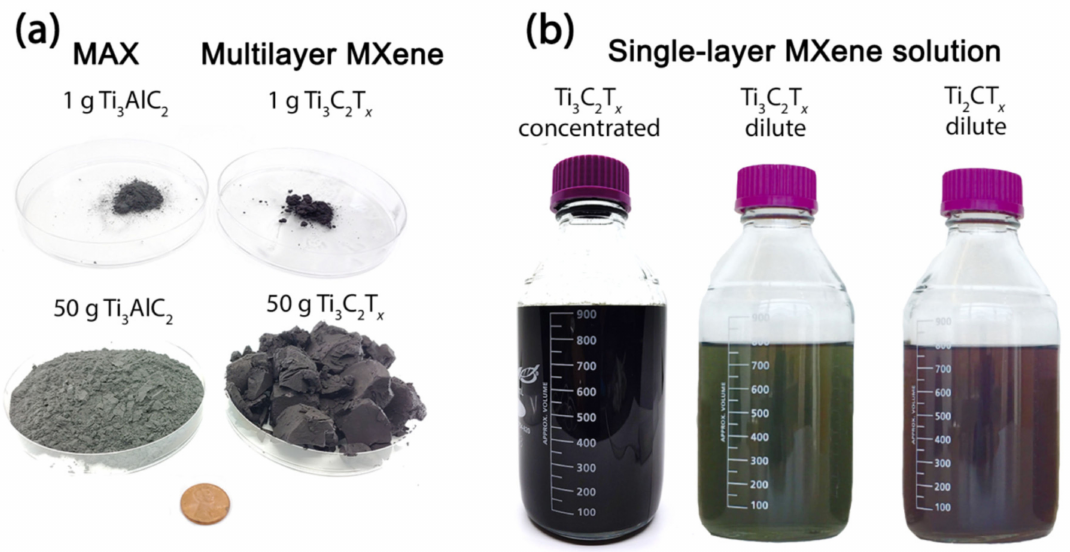
Figure 7. Color change shown by MAX phase and derived MXene. ( a ) Images of the parent Ti 3 AlC 2 MAX phase used in synthesis of the 1 g and 50 g Ti 3 C 2 T x samples. ( b ) Delaminated MXene solutions in 1 L bottles depicting their characteristic colors.Reprinted with permission from refs. [72] (Shuck et al., 2020) and [42] (Alhabeb et al., 2017). Copyright 2020 Elsevier